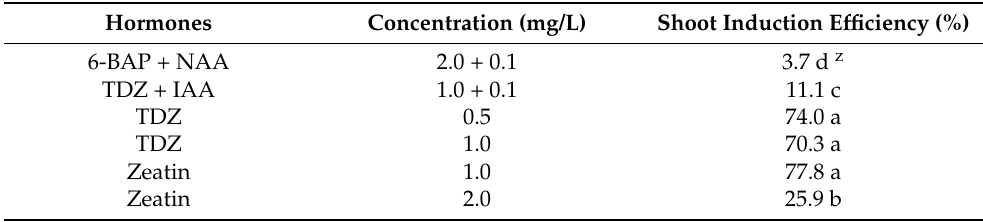
Table 1. Shoot induction efficiency using different hormones.